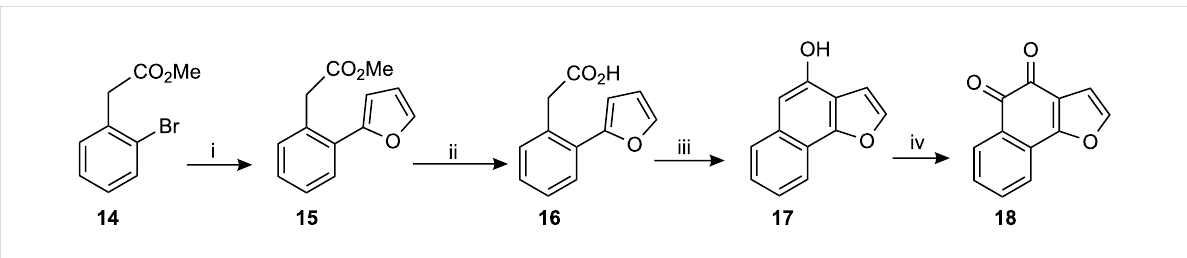
Scheme 2: Reagents and conditions: i) furan-2-boronic acid (1.2 equiv), Et 3 N, DMF, Pd(PPh 3 ) 4 (2 mol %), 110 °C, N 2 atmosphere, 7 h, 84%, ii) KOH, EtOH, H